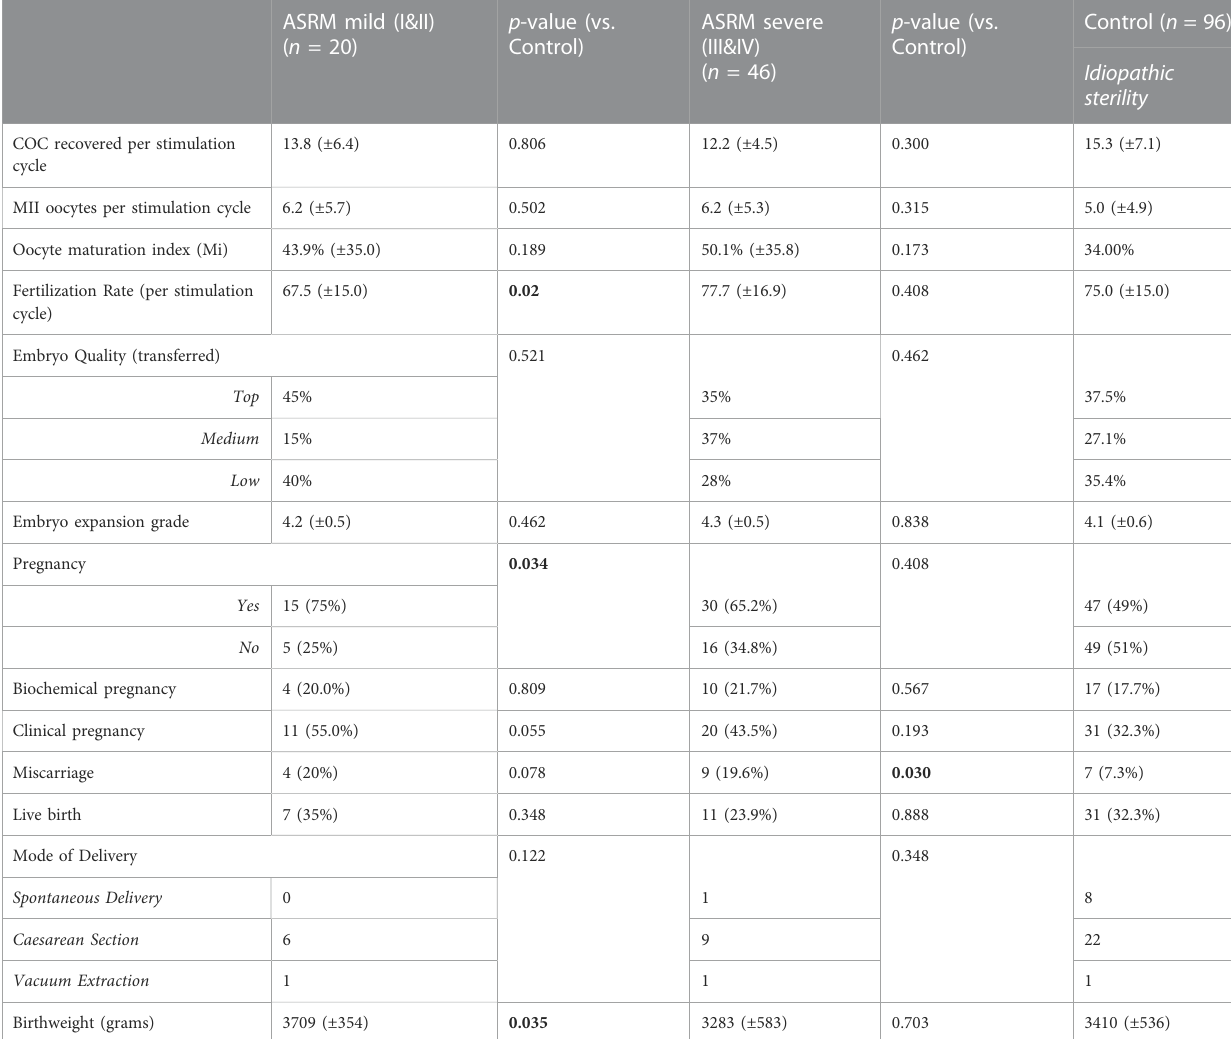
TABLE 3 Treatment cycle primary and secondary outcomes in subgroup analysis of ASRM stages. ASRM mild (I&II) ( n =